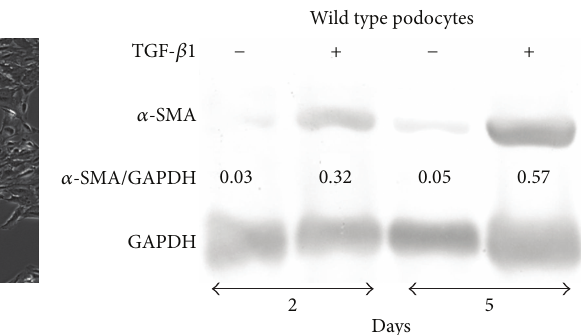
Figure 1: Phenotypic features of wild type (WT) human podocyte cell lines and 𝛼 -SMA expression: effects of TGF- 𝛽 1 treatment. (a) The cells were grown as indicated in Section 2. Prior to the TGF- 𝛽 1 incubation, the cells were starved for 48 hr. The pictures show the cells after 48hr of TGF- 𝛽 1 treatment used at 5ng/mL. The optical images were obtained with a Will (Wetzelar) inverted microscopy at a 10x enlargement. (b) Western blot detection of 𝛼 -SMA. Typically, 30 𝜇 g of total cell lysates was loaded on a 10% polyacrylamide gel. Western blot is described in Section 2. GAPDH expression was used to normalize protein loading. The anti- 𝛼 -SMA mouse monoclonal antibody was purchased from Sigma-Aldrich (St. Louis, MO, USA). The anti-GAPDH (sc-25778) rabbit polyclonal antibody was purchased from Santa Cruz Biotechnologies, (Santa Cruz, CA, USA). To quantify the protein bands, we scanned the blots and performed a densitometry analysis, using the software NIH ImageJ v. 6.4 (freeware, NIH, MD, USA). The figure shows a typical experiment of at least three performed under the same